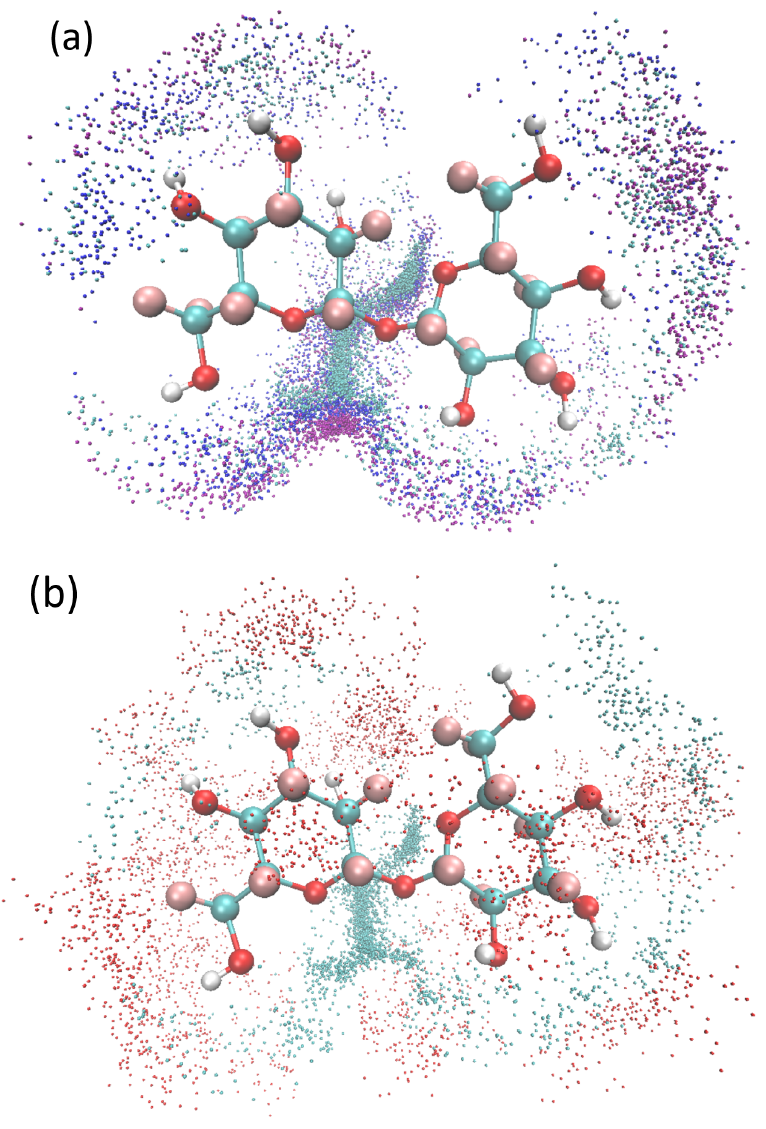
Figure 3. The schematic diagram of the accumulation of alkali metal ions and urea molecules around trehalose. ( a ) Li + (blue dots), Na + (dark blue dots), K + (red dots) ions are distributed around a trehalose molecule. ( b ) Distribution of Li + and the oxygen atoms of urea (red dots) around a trehalose molecule.